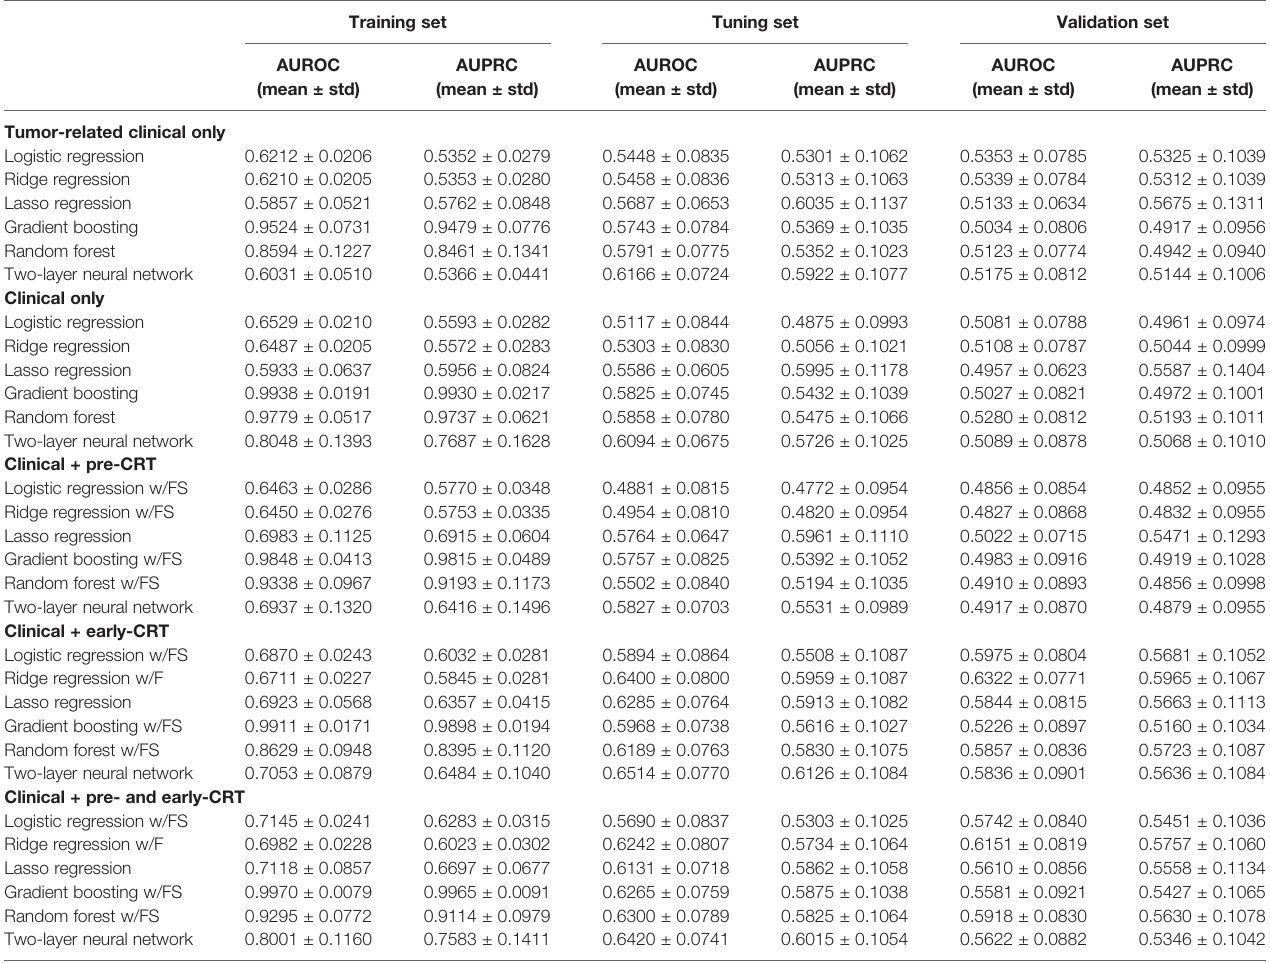
TABLE 1 | Performance comparison of a total of 18 models for 1,000